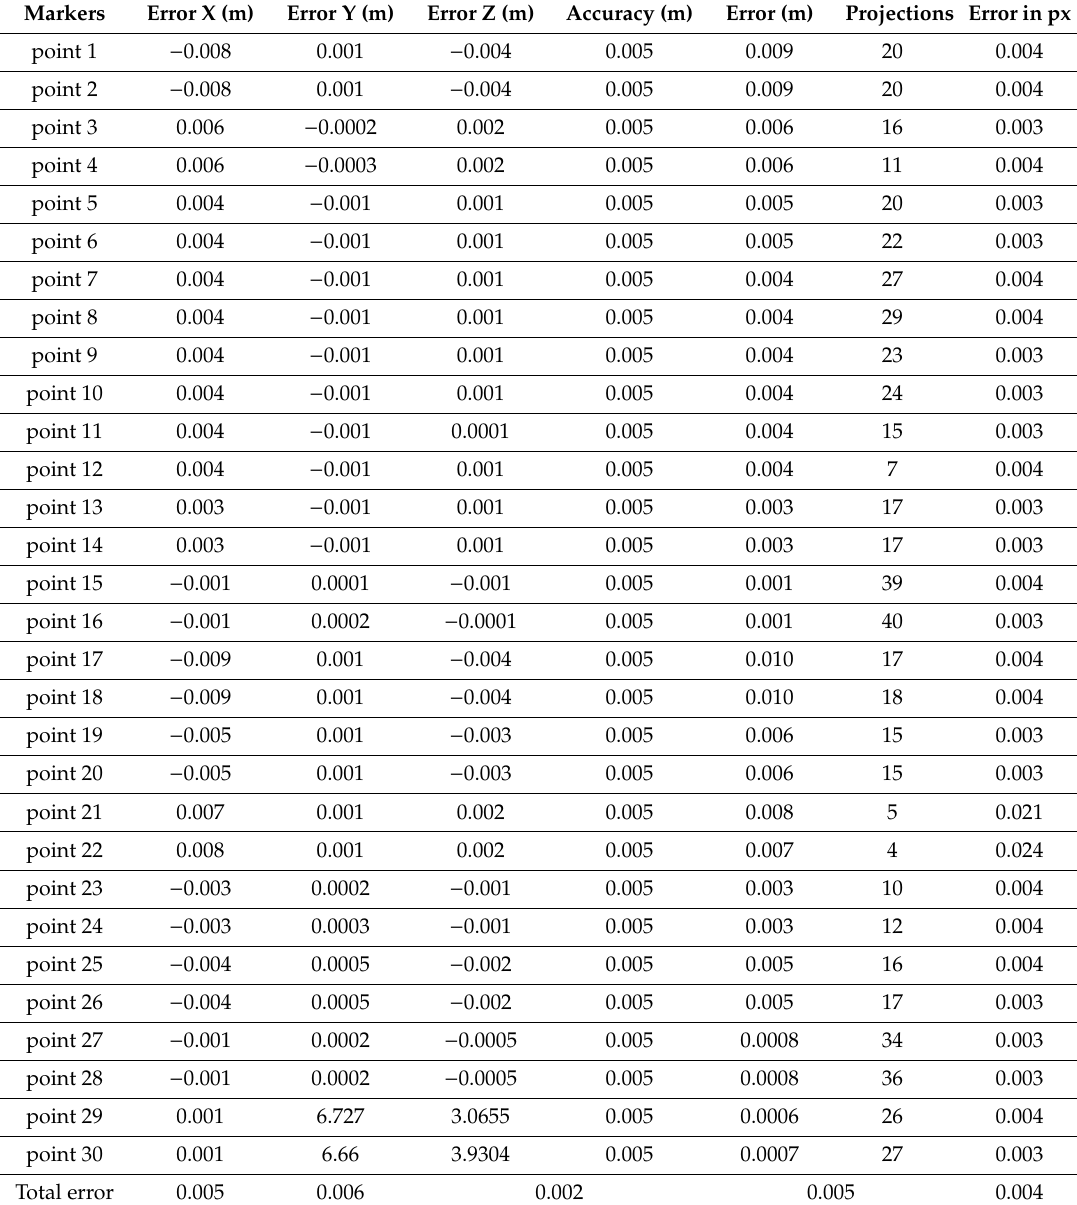
Table 2. Error (pix): root mean square re-projection error calculated over all feature points detected on the